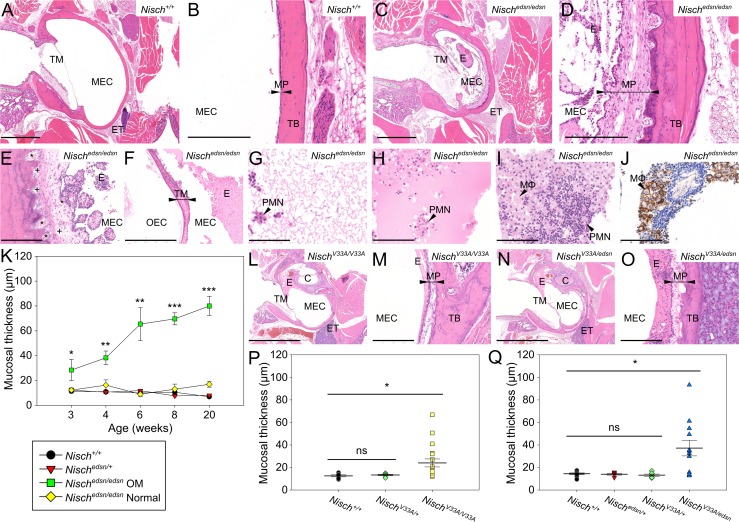
Middle ear histology indicates chronic otitis media in Nischedsn/edsn mice.(A-D) H&E stained transverse sections of the MEC and mucoperiosteum, in 20 wk (A, B) Nisch+/+ and (C, D) Nischedsn/edsn mice. Wild-type animals have no inflammation or exudate in the MEC and a thin mucoperiosteum covers the temporal bone. Nischedsn/edsn mice exhibit chronic inflammation with an exudate and thickened mucoperiosteum. (E, F) Additional characteristics of chronic OM in Nischedsn/edsn middle ears; changes include (E) fibrous polyps, with dilated lymphatic (+) and blood vessels (*) in the mucoperiosteum, and (F) fibrous thickening of the tympanic membrane. (G-I) Differing types of middle ear effusion; from (G) a thin watery effusion, (I) a dense granulocyte-rich effusion, or (H) a combination of both. (J) Immunohistochemical staining of a Nischedsn/edsn ear with OM using an F4/80 antibody shows a cellular exudate rich in macrophages (brown). Representative image from four mice (K) Blinded assessment of mean mucosal thickness displays a progressive thickening in Nischedsn/edsn ears with OM, showing significant increases throughout the study. There is no histological difference seen in mean mucosal thickness between Nischedsn/edsn Normal ears and wild-type littermates. The criteria used to impartially categorise the ears into Nischedsn/edsn OM and Nischedsn/edsn Normal was from visualisation of tympanic membrane. Nisch+/+ n = 10–14; Nischedsn/+ n = 10–22; Nischedsn/edsn OM n = 8–16; Nischedsn/edsn Normal n = 3–10. (L, M, N, O) H&E stained transverse sections of the MEC and mucoperiosteum, in 12 wk (L, M) NischV33A/V33A and (N, O) NischV33A/edsn mice, displaying chronic OM in both. (P, Q) Blinded assessment of mean mucosal thickness shows significant increases in both (P) NischV33A/V33A and (Q) NischV33A/edsn mice. Combined data is presented including mice with OM and mice with clear ears. (P) Nisch+/+ n = 6; NischV33A/+ n = 6; NischV33A/V33A n = 18. (Q) Nisch+/+ n = 10; Nischedsn/+ n = 6; NischV33A/+ n = 6; NischV33A/edsn n = 12. C, cochlea; ET, eustachian tube; E, exudate; MΦ, foamy macrophage; MEC, middle ear cavity; MP, mucoperiosteum (arrowheads); PMN, polymorphonuclear cells; TB, temporal bone; TM, tympanic membrane; *, blood vessels; +, lymphatic vessels. A, C, L, N scale bar = 2 mm; F scale bar = 500 μm; B, D, E, M, O scale bar = 200 μm; G-J scale bar = 100 μm. * P < 0.05; ** P < 0.01; *** P < 0.001. Error bars indicate standard error of mean. A Kruskall-Wallis test was performed followed by Dunn’s multiple comparison tests for post-hoc analysis.